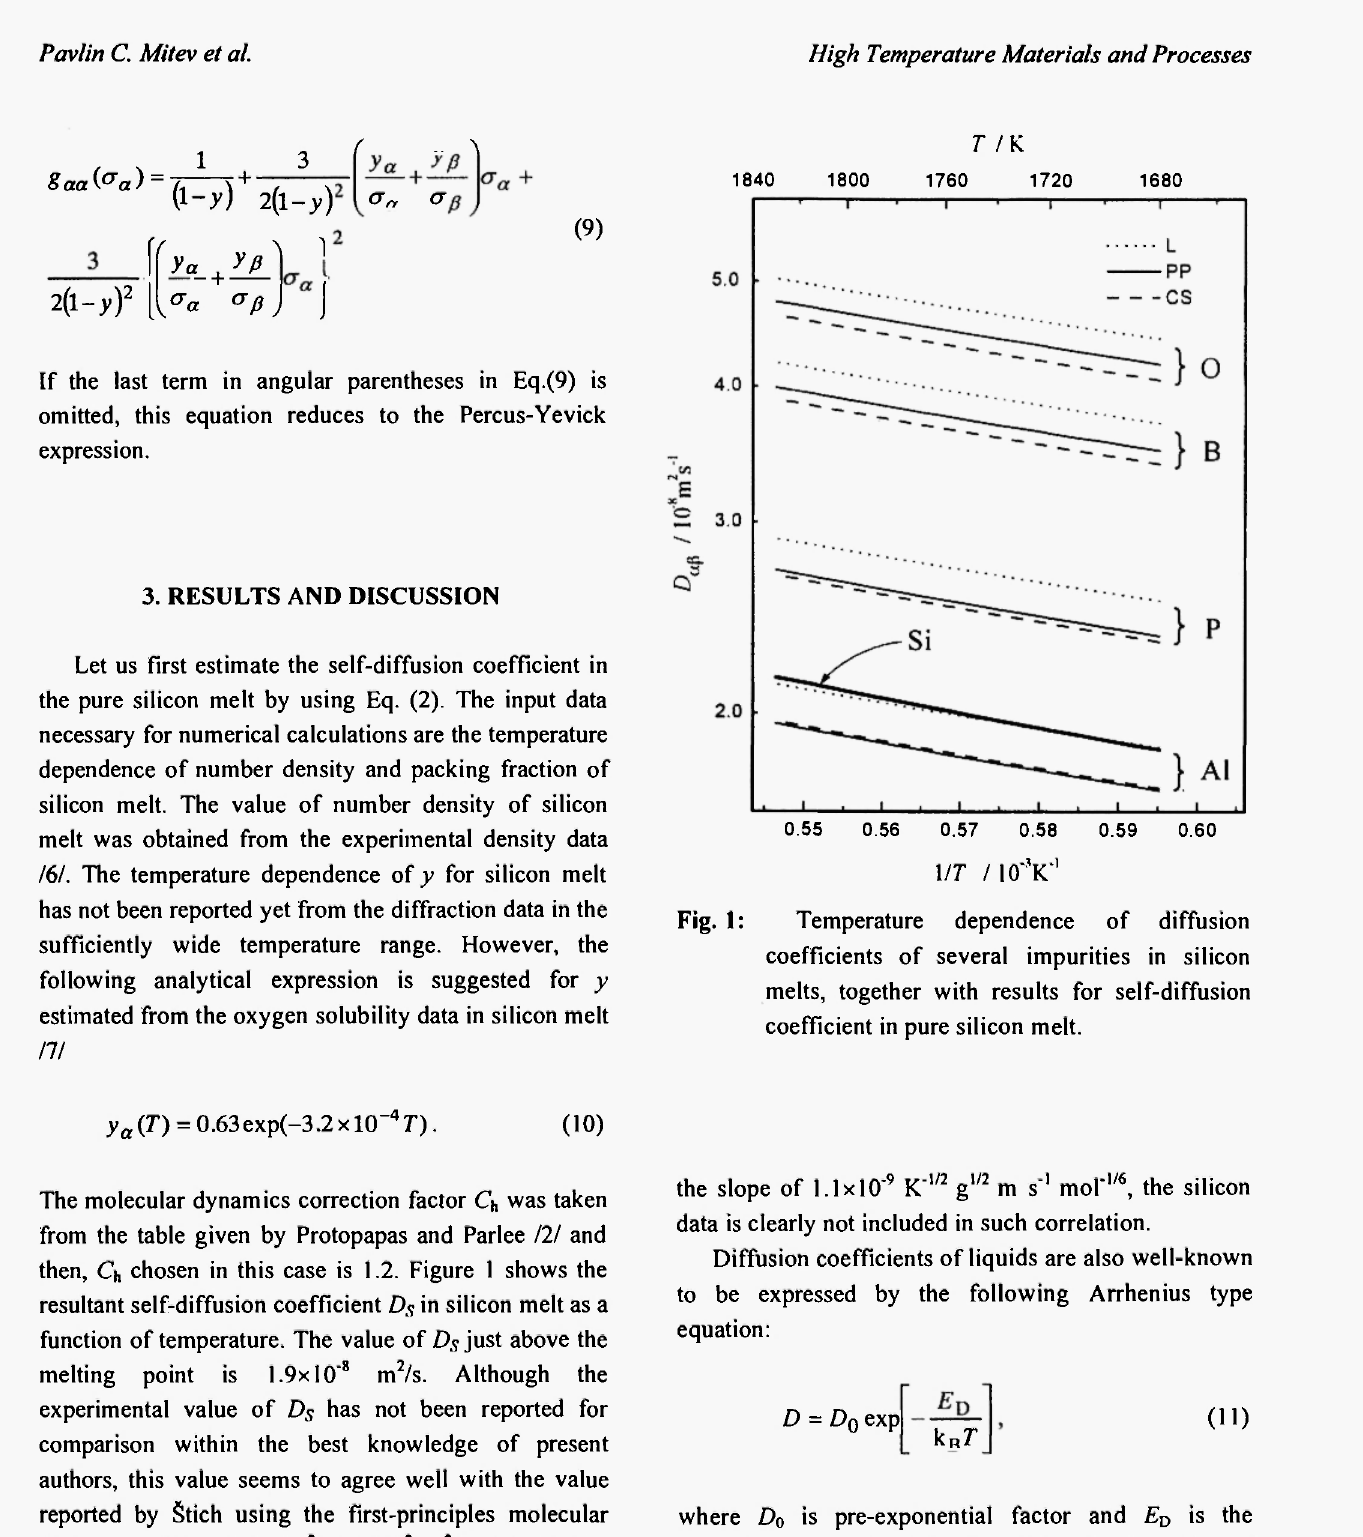
Fig. 1: Temperature dependence of diffusion coefficients of several impurities in silicon melts, together with results for self-diffusion coefficient in pure silicon